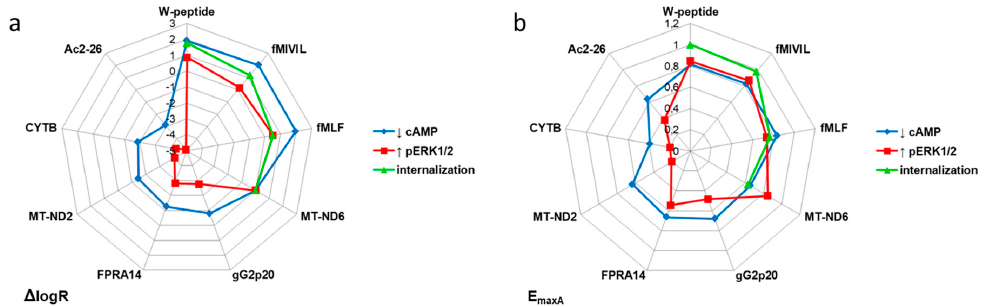
Figure 8. Graphical representation of the agonist profiles. Relative agonist activities corresponding to the Δ logR values and the logistic parameters ( a ) EC 50 and ( b ) E maxA for the respective pathways are depicted in radial graphs. Each radius for Δ logR is displayed in the logarithmic scale, radiuses for E max are scaled linearly.